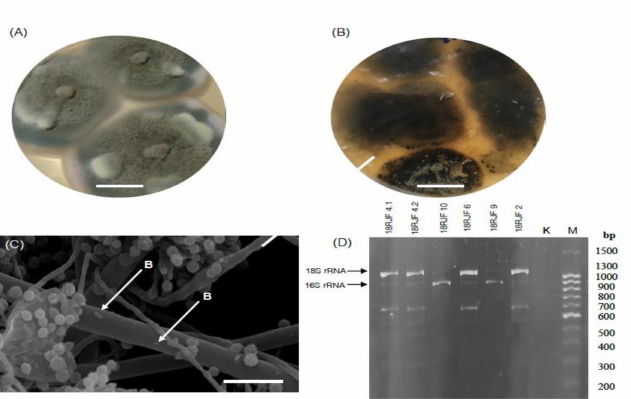
Figure 2. Analysis of the bacterial component of the communities isolated from the TS-1 jet fuel. ( A ) Native cultures of the micromycetes. Scale bar: 10 mm. ( B ) Mycelium lysis. Scale bar: 10 mm. ( C ) Bacteria attachment to the fungal hyphae in the isolate 18RJF9. Scale bar: 10 µ m, arrows indicate the bacterial cells—B. ( D ) Separation of the PCR products obtained by using the primers for 16S rRNA detection in agarose gel. K is the negative control; M is the 100+ bp DNA